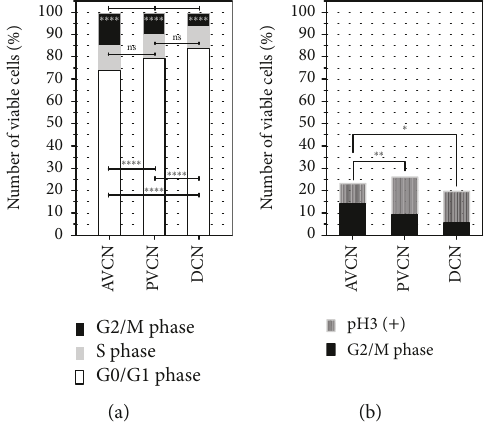
Figure 8: Quanti fi cation of fl ow cytometry analyses from CN NSCs — divided into AVCN, PVCN, and DCN. (a) Quanti fi cation of propidium iodide cytometry populations: G2/M, S, and G0/G1 phase. The signi fi cantly largest proportion of cells in the G0/S1 phase was determined in the DCN, and the smallest proportion in the AVCN. There were no signi fi cant di ff erences between the fractions in the S phase. The largest proportion of cells in the G2/M phase was found in the AVCN, and the smallest in the DCN. (b) Quanti fi cation of the G2/M phase population and the proportion of anti-phospho-histone-H3-positive cells. Within the G2/M phase populations, the PVCN showed the signi fi cantly largest proportion of cells in which the mitotic marker phospho-histone-H3 was stained positively. The smallest share was in the AVCN. The bar graphs demonstrate the median values; asterisks indicate the signi fi cance level: ∗ p < 0 : 05 , ∗∗ p < 0 : 005 , ∗∗∗ p < 0 : 001 , and ∗∗∗∗ p < 0 : 0001 ; n = 3 .